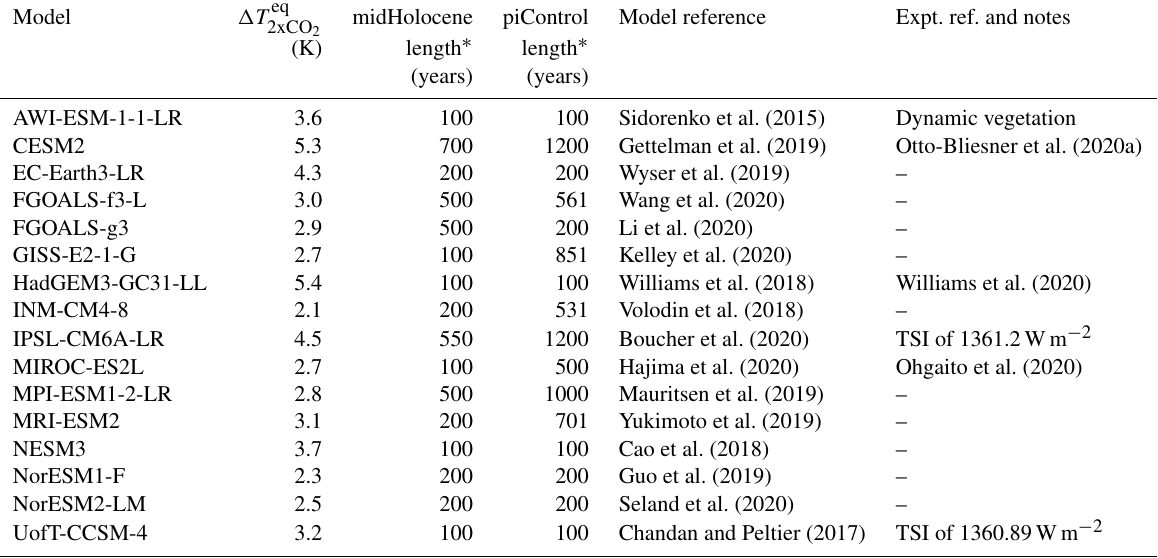
Table 1. Models contributing midHolocene simulations under CMIP6. See Table S1 for further information about the individual simulations. Model